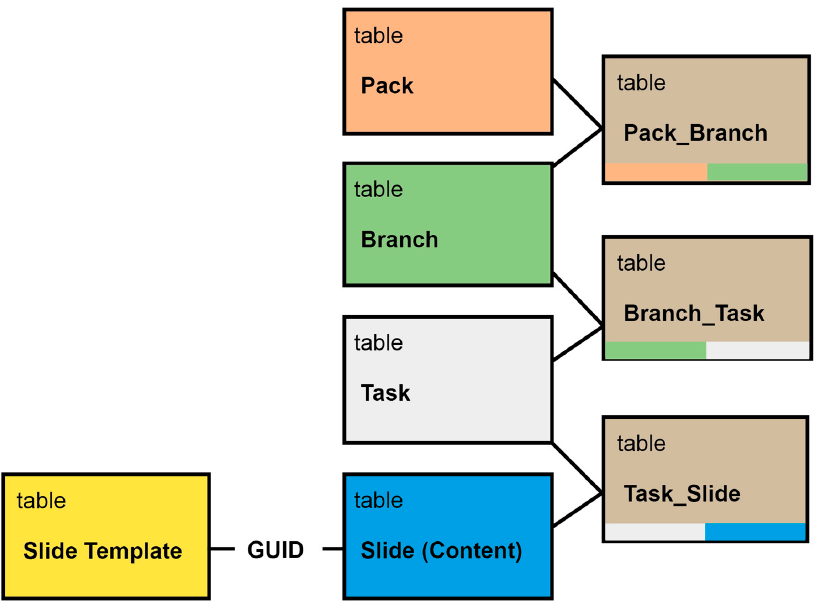
Figure 2. The content of Slide, Task and Branch Tables is associated with a higher level in